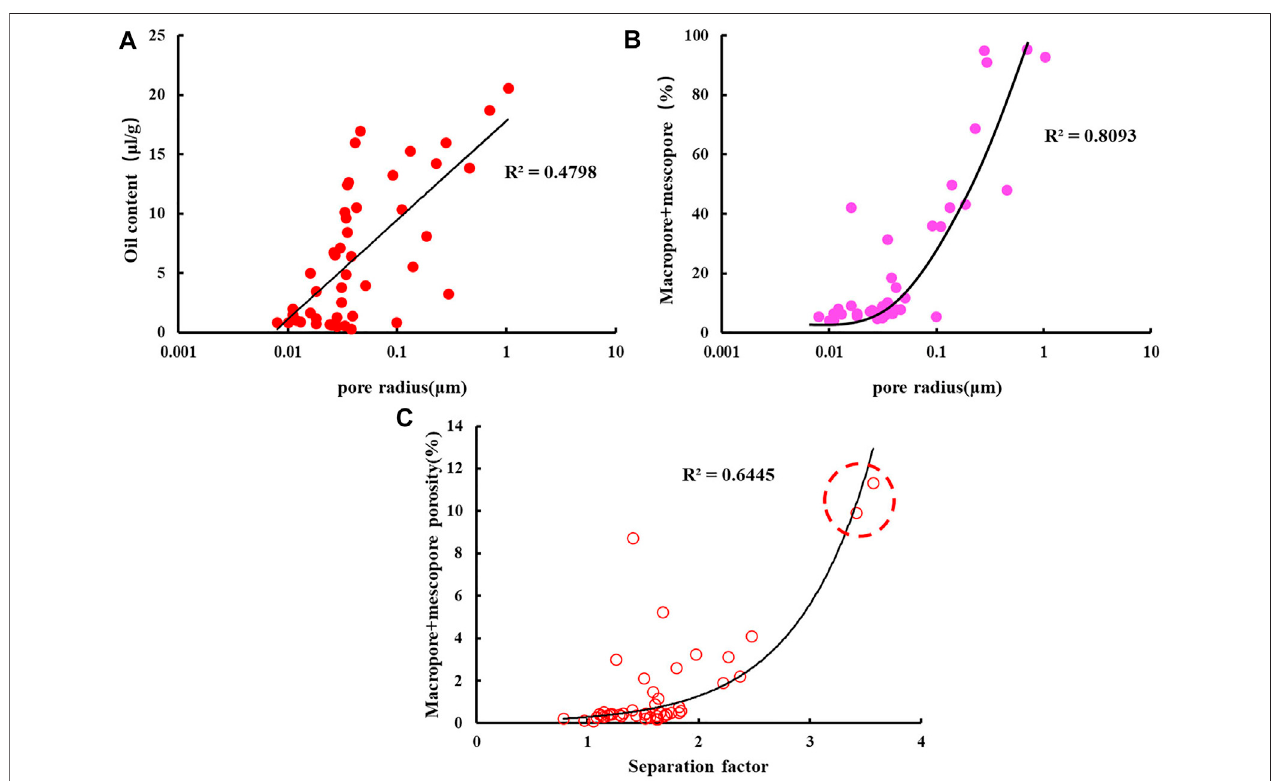
FIGURE 13 | The relationship between pore structure and oil content. (A) The relationship between pore radius and oil content. (B) The relationship between pore radius and the proportion of macropore and mescropore. (C) The relationship between pore radius and macropore and mescropore porosity.